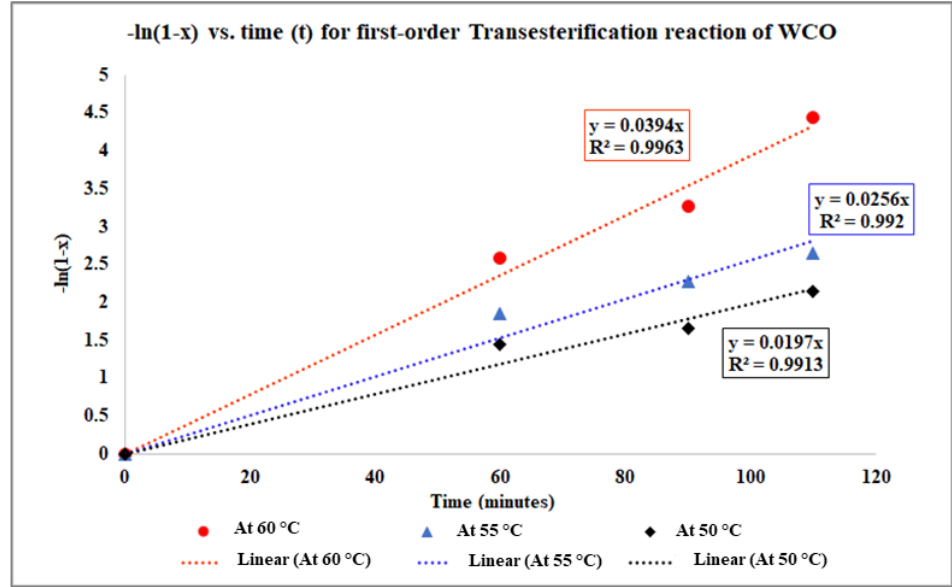
Figure 19. Determination of the reaction rate constant for the transesterification process of WCO. Comparing the regression fits of Figure 19 with − ln(1 − 𝑥) = 𝑘 1 𝑡 [37], the values of 1/T and lnk 1 can be determined as presented in Table 3. Table 3. Determination of 1/T and lnk 1 for the WCO transesterification kinetics. T (°C)